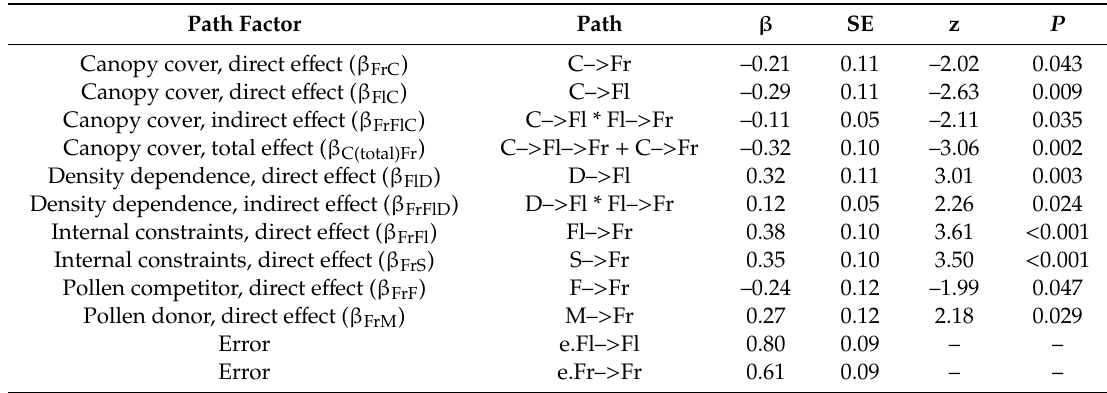
Table 2. Direct and indirect path relationships (hypotheses) and their coe ffi cients ( β ) from a path model relating flower and fruit production for a population of Shepherdia canadensis in Edmonton, Alberta, Canada 1